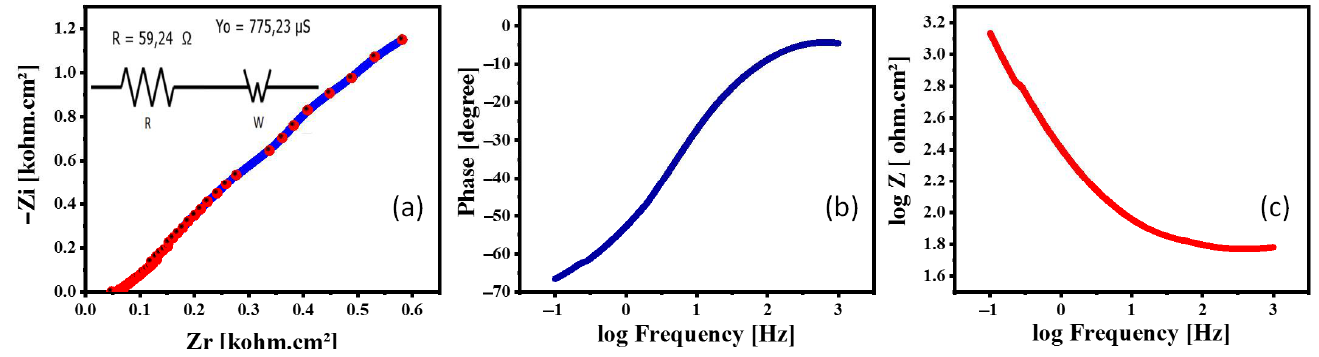
Figure 7. The SS1.5 photocathode impedance in 0.5 M (Na 2 SO 3 · 7H 2 O) electrolyte at RT under white- light illumination; ( a ) the Nyquist Z plot and the equivalent circuit, ( b , c ) Bode plots: ( b ) the variation in phase with frequency and ( c ) the change in total impedance with frequency.